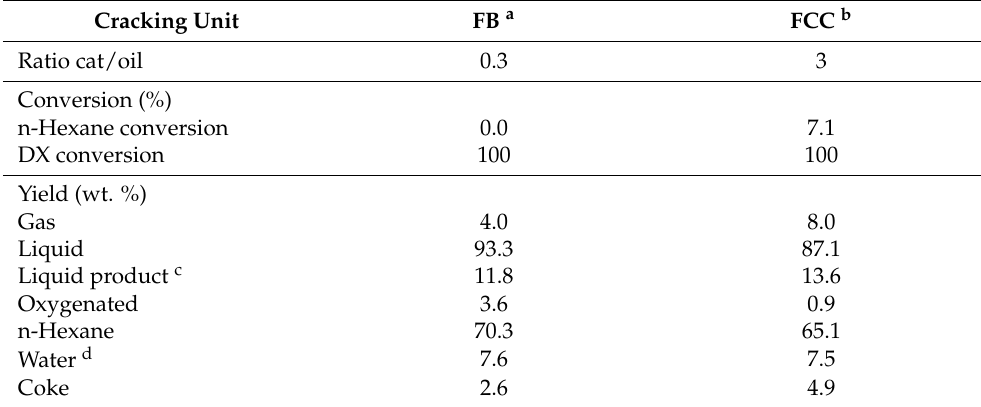
Table 6. Hydrothermally treated beta catalyst (DAD) with different cat/oil ratios for fixed-bed and fluidized-bed